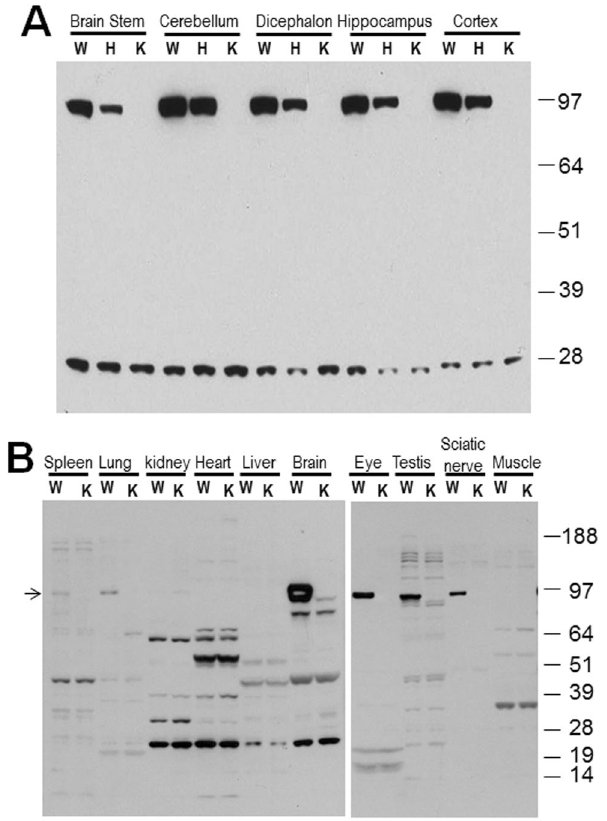
Figure 2. RTN1 deficiency increases RTN3 protein levels. ( A ) Protein lysates were prepared from different brain regions as indicated, and RTN1 was shown to be broadly expressed in all examined brain regions. This result shows mice at 6 months of age. Only RTN1-A was detected by antibody R418. A cross-reacted protein migrated near 25 kd and was detected in all WT, heterozygous, and homozygous RTN1-null mice. ( B ) Equal amounts of protein lysate from the indicated tissues were examined by the same procedure, and lysates from the brain cortex were used to locate the RTN1 isoform and to compare expression of RTN1 across different tissues. Arrow specifies the longest RTN1 isoform detected in brain. Non-specifically reactive bands would be sparse if more stringent western blot conditions such as those in panel A were